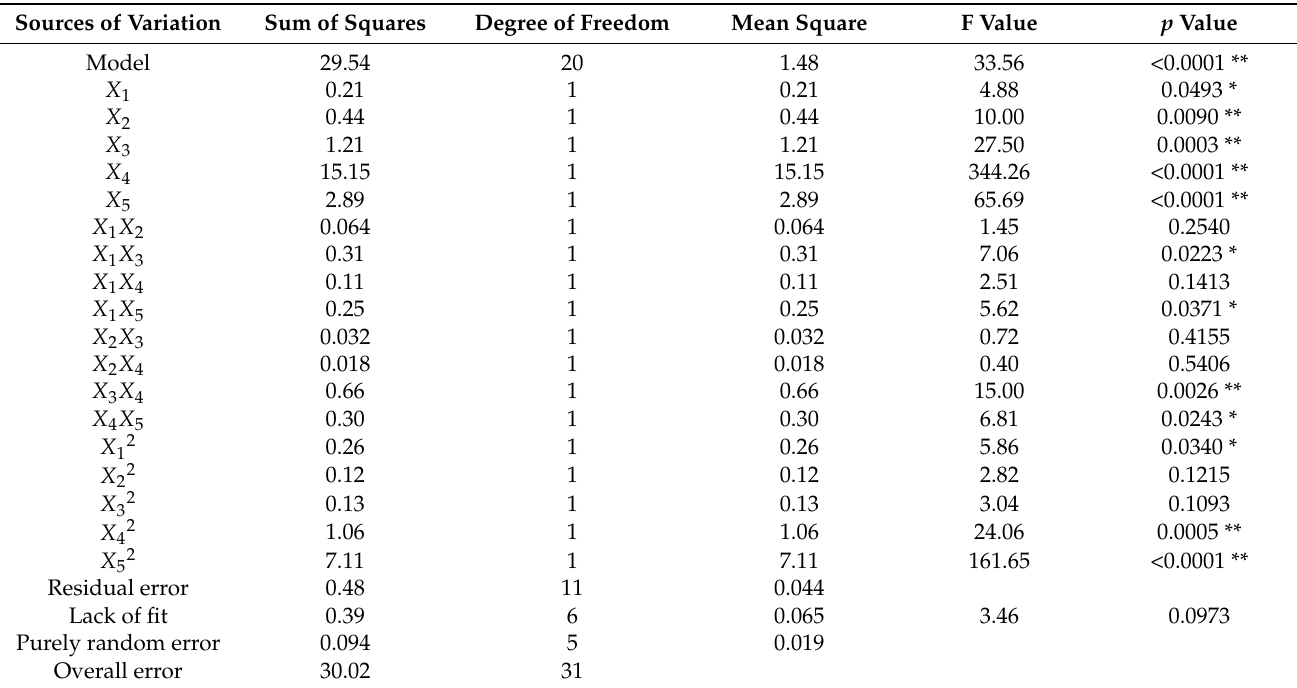
Table 3. ANOVA for response surface quadratic